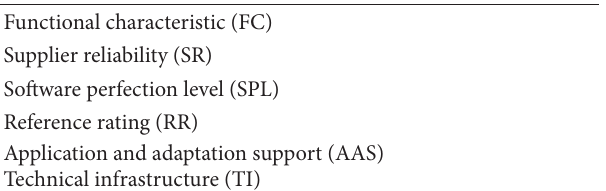
Table 3: Fuzzy TOPSIS evaluation values. Table 4: The